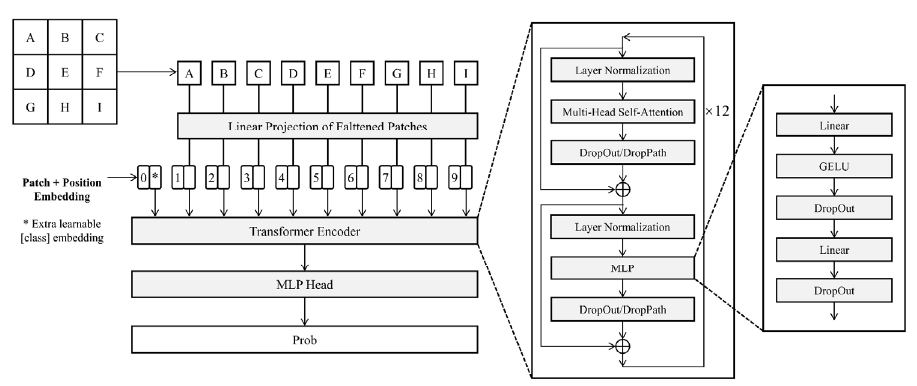
Figure 4. ViT network structure.